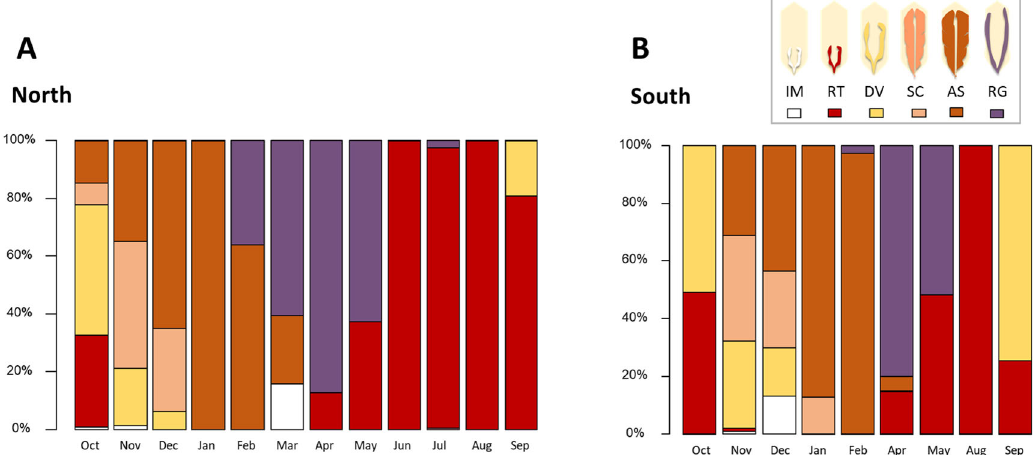
Figure 2. ( A , B ) Monthly variations in the relative frequency of gonad developmental phases in sardines captured on the northern coast and in the southern coast, respectively (from October 2019 to July 2021). Along the southern coast, samples could not be collected during March, June and July because of COVID-19 restrictions. Gonad developmental phases are classified into immature (IM), regenerating (RT), developing (DV), spawning capable (SC), actively spawning (AS), and regressing (RG) stages.